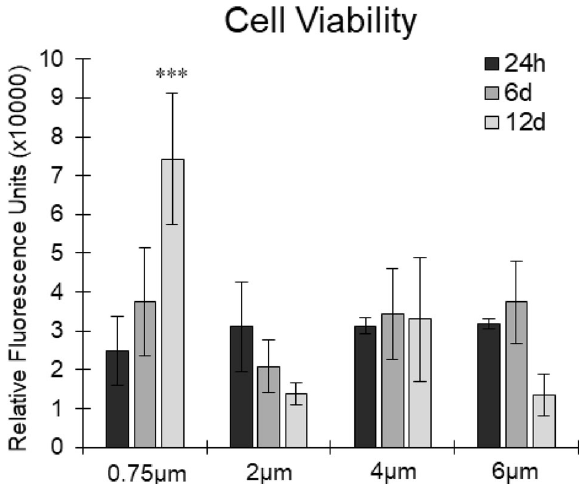
Fig. 5 Cell viability of HUVSMCs on all four scaffolds after 1, 6 and 12 days of culture. n = 4, error bars = SD, *** p <